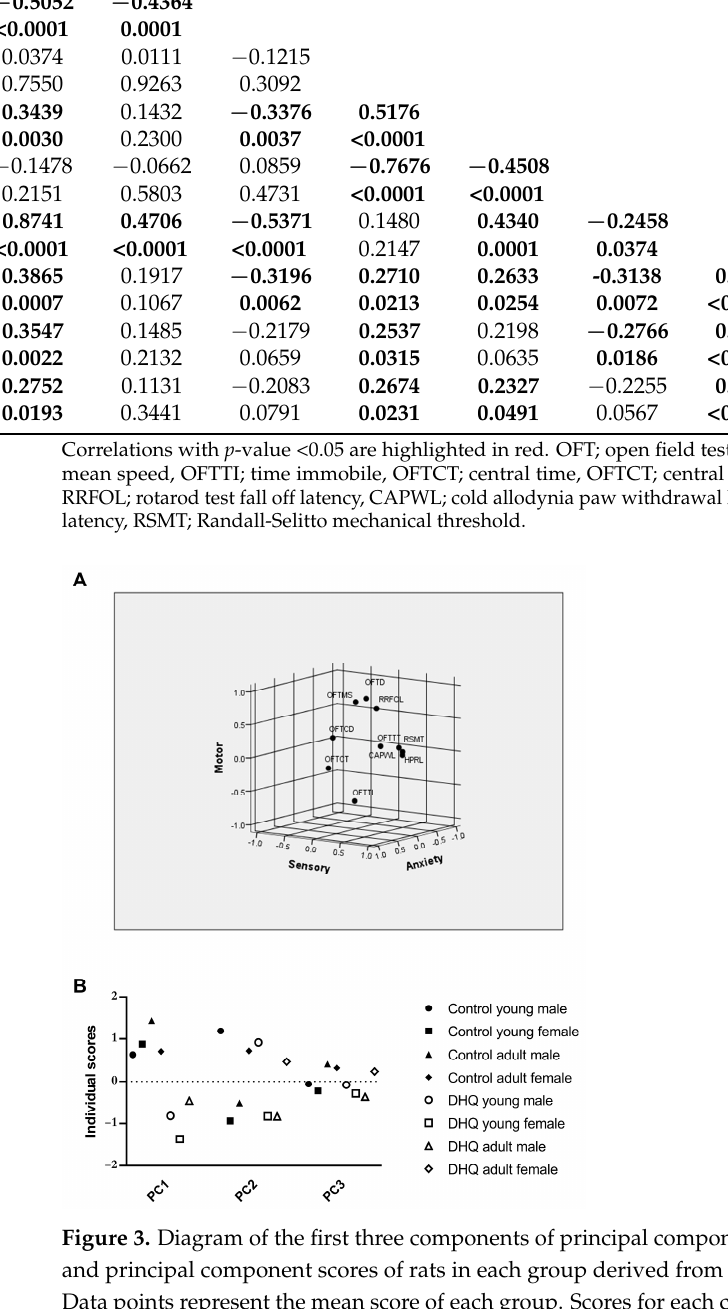
Table 2. Rotated (Varimax-Kaiser normalization) matrix of extracted components with eigenvalue > 1.